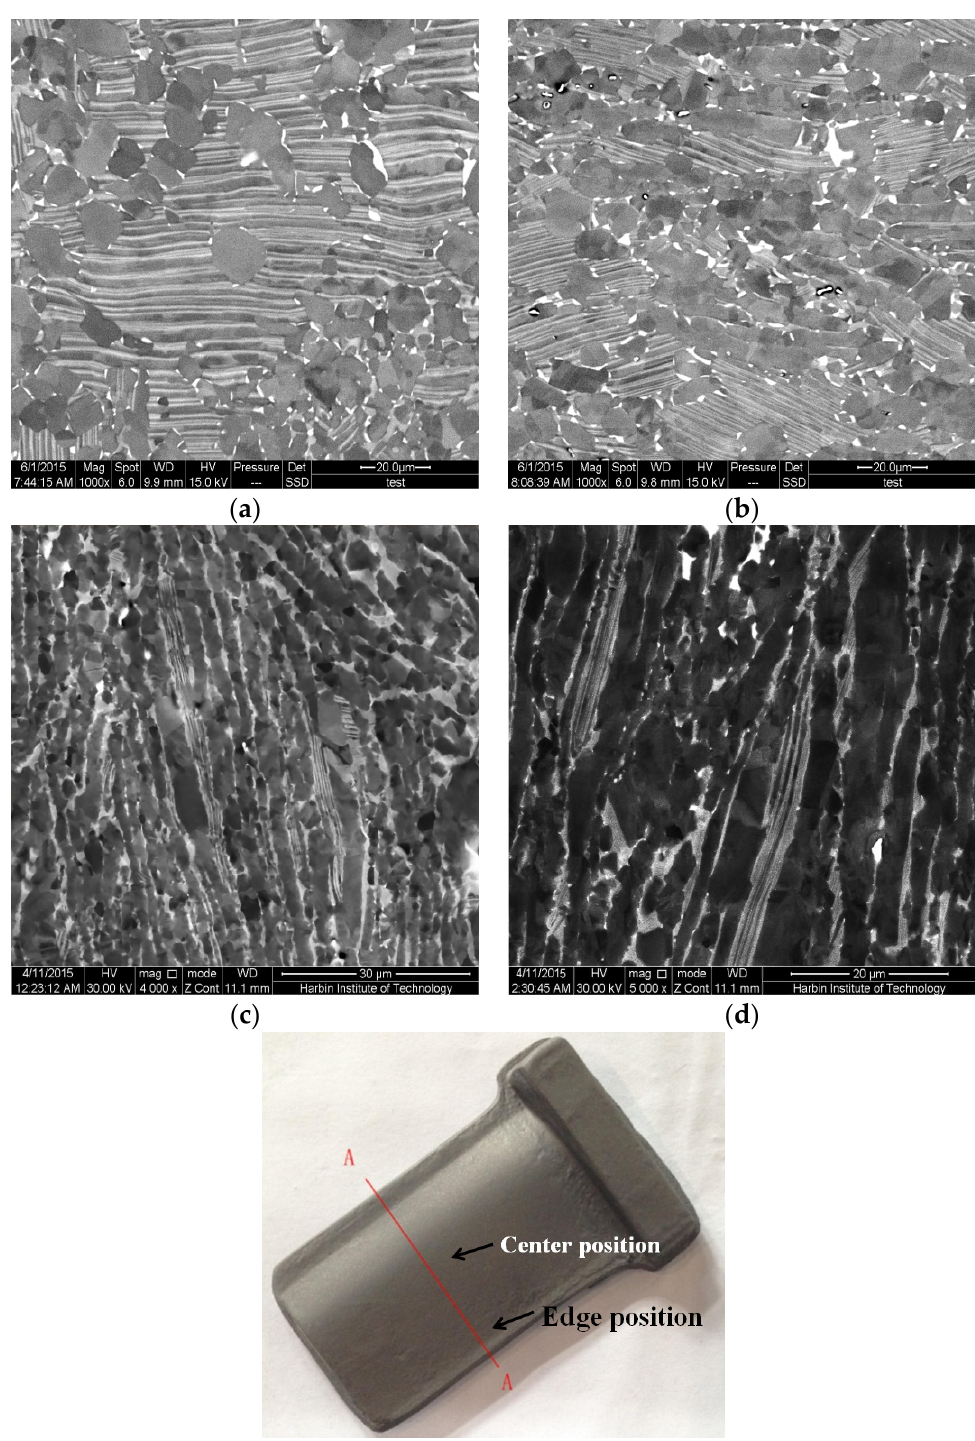
Figure 9. Microstructure of TiAl alloy before and after the isothermal die forging: ( a ) before the isothermal die forging; ( b ) center position of the forged blade; ( c ) edge position of the forged blade; ( d ) high magnification of ( c ); ( e ) sample position of ( b ) and ( c ) in the forged blades.